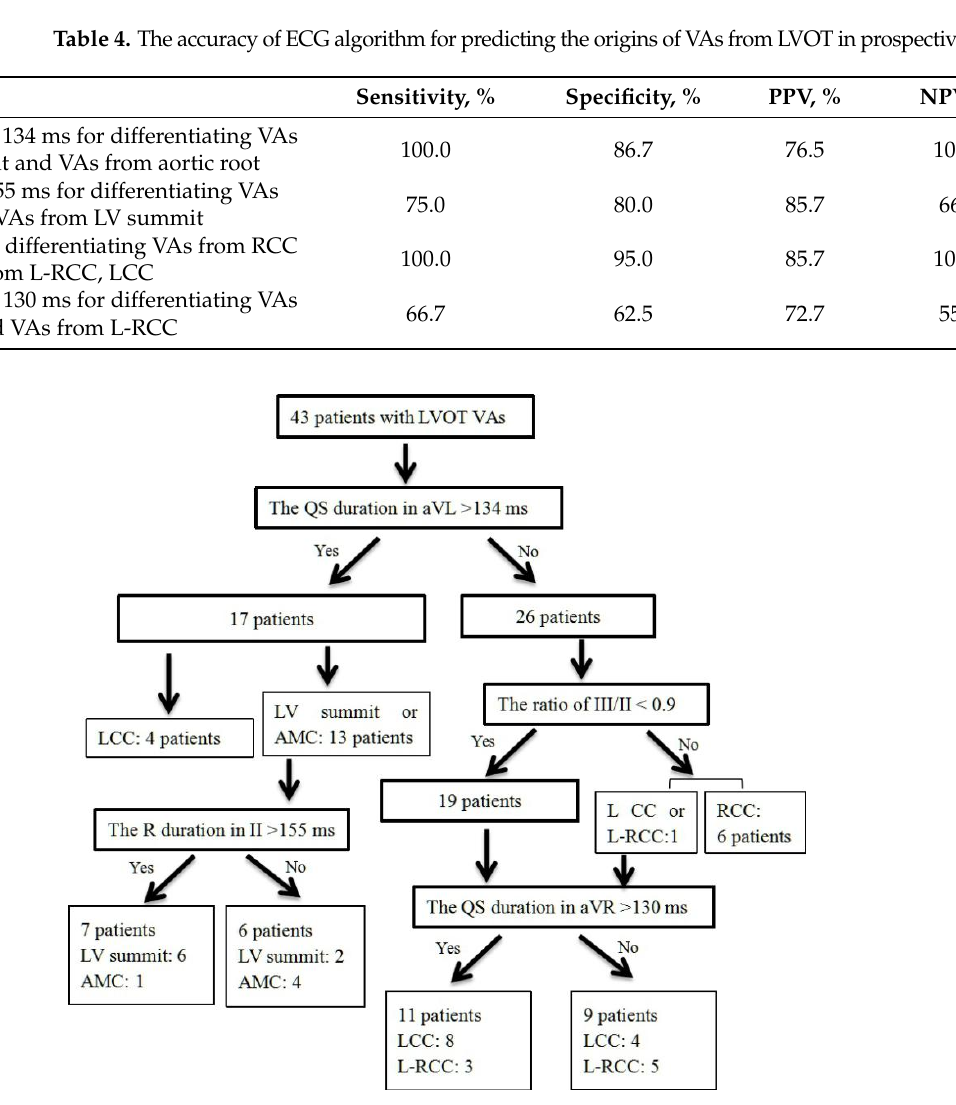
Figure 4. Process of validation in the prospective cohort patients.